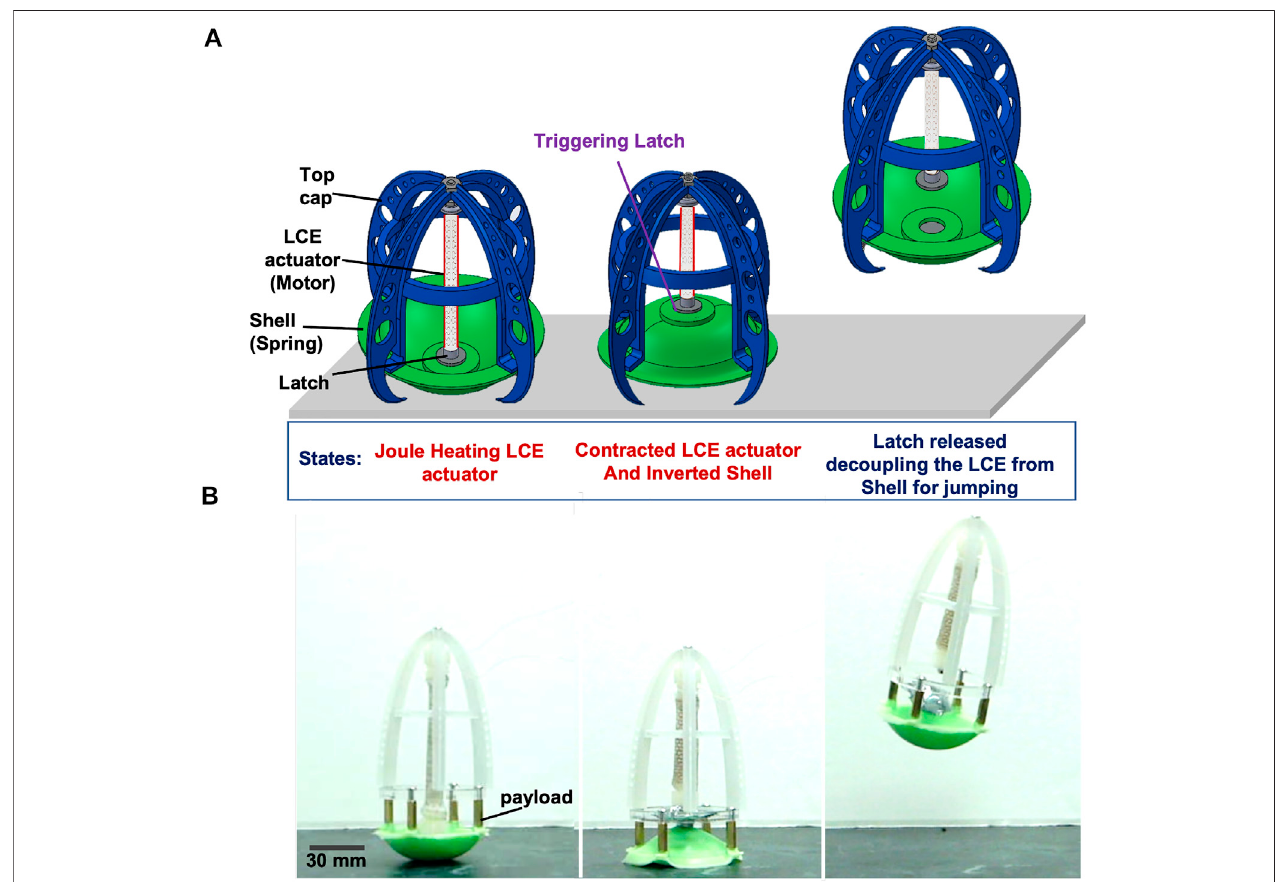
FIGURE1| Softjumpingrobotwiththesoft-powerampli fi cationsystem.Thebasicdesignconsistsofanactuator(withonesideconstrainedbyastiffpart,suchas the top cap) that slowly compresses a spring (i.e., inverts an elastic shell), and a latch that quickly releases the stored energy for jumping: (A) Conceptual schematic indicating the states of the soft robot for jumping using the soft ampli fi cation system: initial state starting the actuation of the LCE muscle (left); upon activation of the musclebyjouleheating,itcontracts,invertingtheshell(middle);whenthelatchistriggered,themuscledecouplesfromtheshell,allowingthelattertosnap-backto the ground and propel the robot into the air. (B) Images from experiments depicting the steps described in (A) of the implemented design concept, in the same order, with added payload (with mass of 20 g).